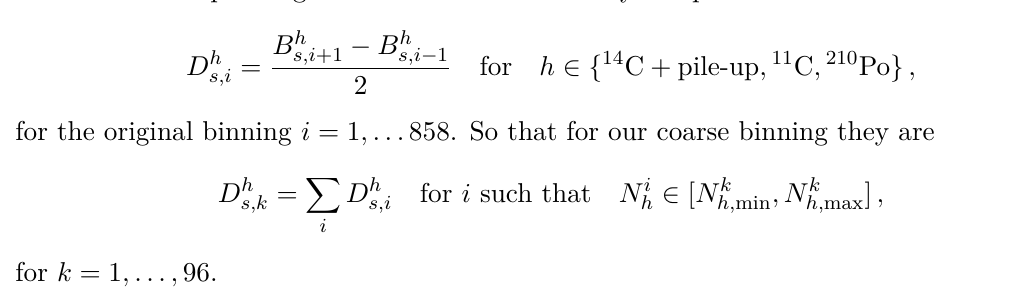
Their corresponding derivatives are numerically computed